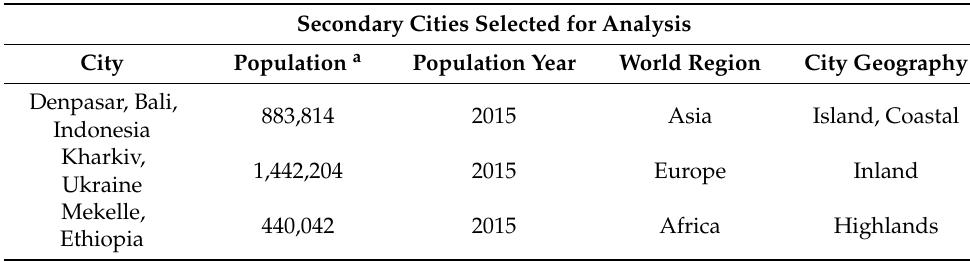
Table 1. Three Secondary City Initiative cities used to calculate SDG Indicator